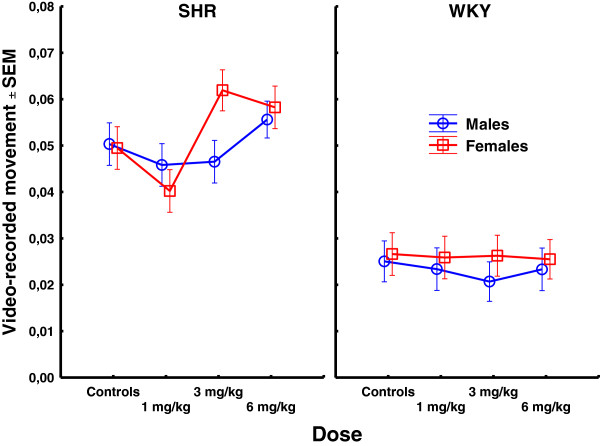
Video-recorded movement (square root-transformed ratio of frame-to-frame pixels-change) across sessions 30 and 39 in SHR/NCrl and WKY/NHsd, males and females, exposed to 1, 3, or 6 mg/kg PCB 153 or to corn oil only. The data suggest a non-linear dose–response relationship in SHR/NCrl females.